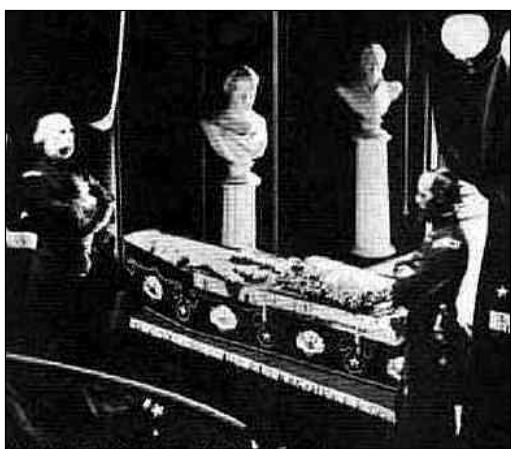
Figure 3. Photograph of Abraham Lincoln’s open casket lying in state, April